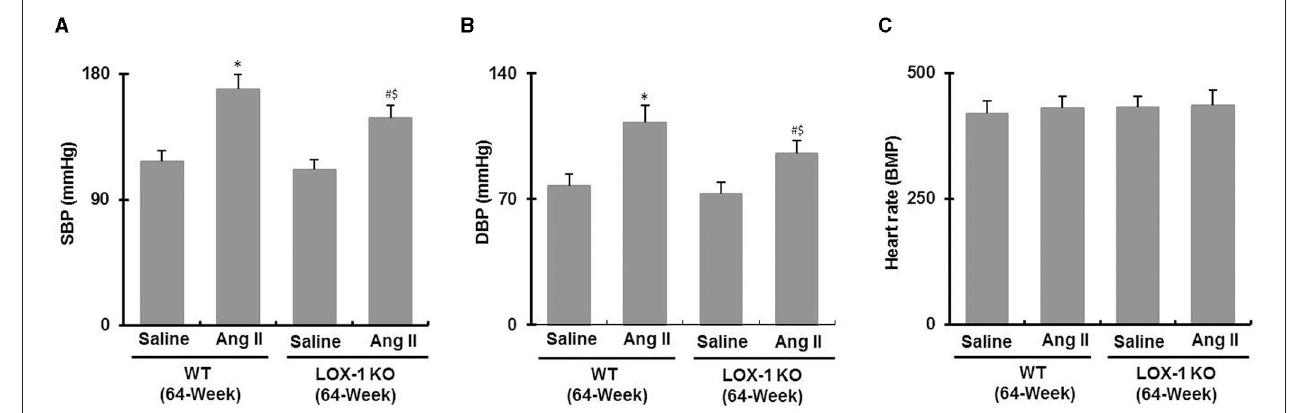
FIGURE 3 | Blood pressure and heart rate in each group of mice following infusion with Ang II or saline for 4 weeks. (A) Systolic blood pressure (SBP); (B) diastolic blood pressure (DBP); (C) heart rate. n = 6 /group. * P < 0.05, vs. WT + saline group; # P < 0.05, vs. LOX-1 KO + saline group; $ P < 0.05, vs. WT + Ang II group.